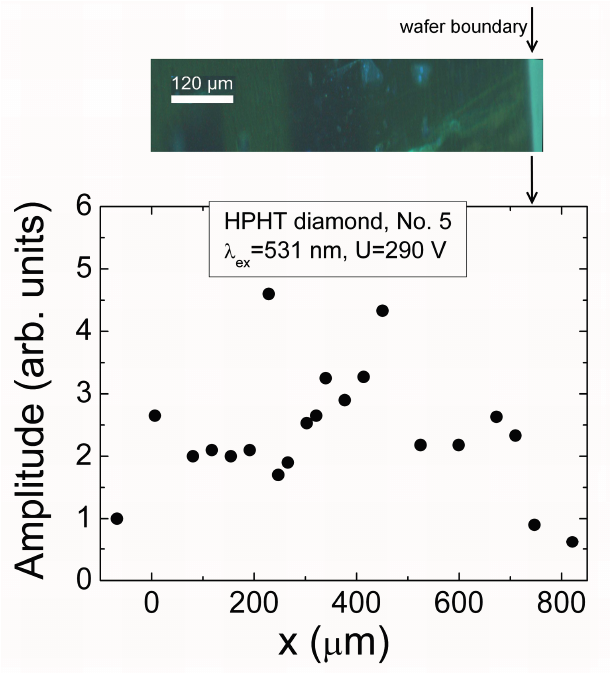
Figure 12. The cross-sectional profile of the peak values of current induced by scanning location of a focused injection beam of 531 nm light, obtained for HPHT diamond sample No. 5. The microscopy image of wafer boundary taken in UV light for the scanned area is shown on top of the current distribution profile plot, where the extended defects are imaged by luminescence spots (bright-blue) within bulk of